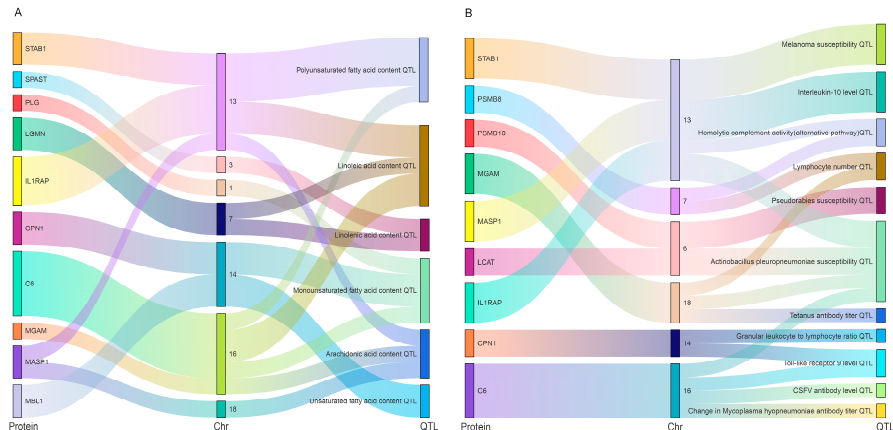
Figure 9. In-depth analysis of potential biological functions of 15 key proteins based on pig quantitative trait locus (QTL) data and protein co-localization analysis. ( A ) The intersection of 15 key proteins with polyunsaturated fatty acid-related QTL data; ( B ) The intersection of 15 key proteins with pig immunity-related QTL data.